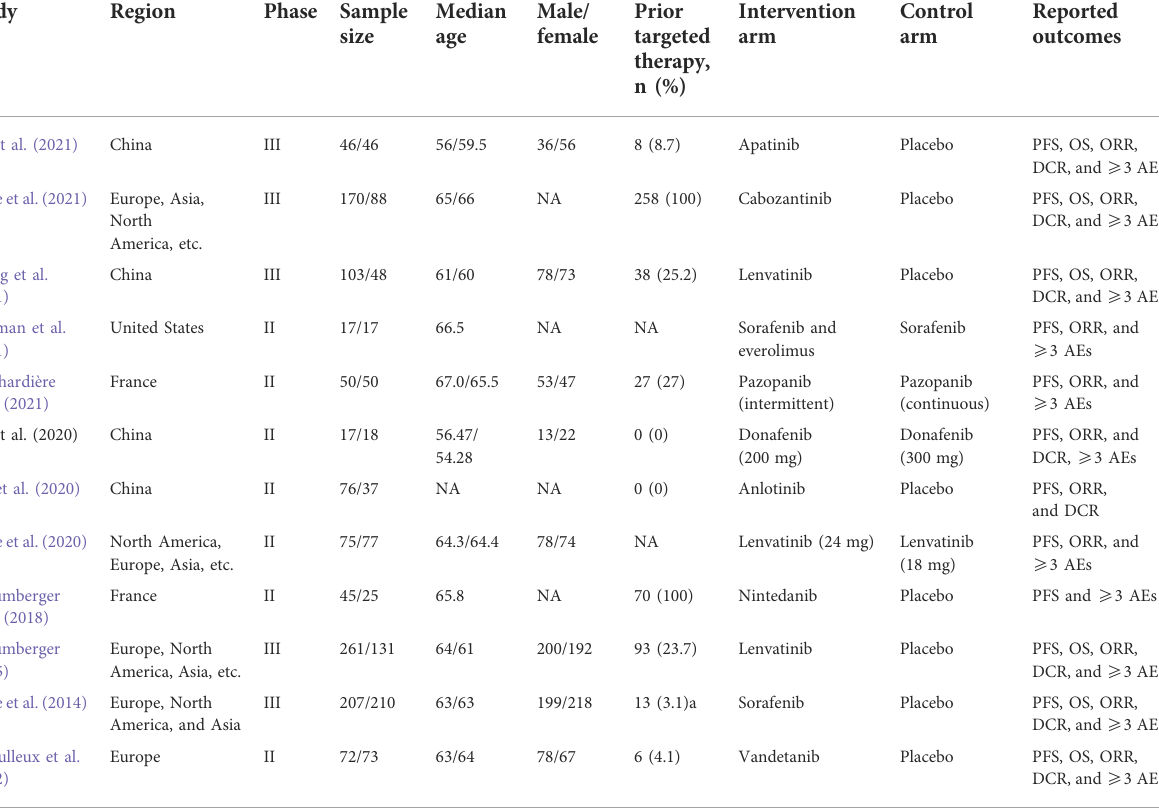
TABLE 1 Baseline characteristics of trials included in the network meta-analysisof patients with radioiodine-refractory differentiated